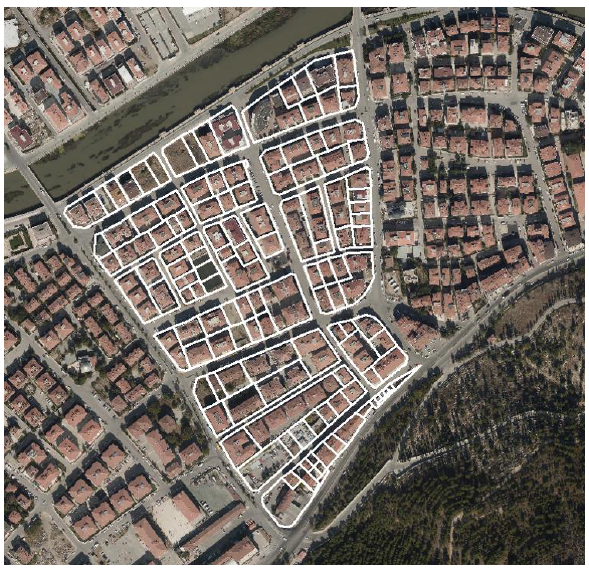
Figure 2 . Gökmedrese County